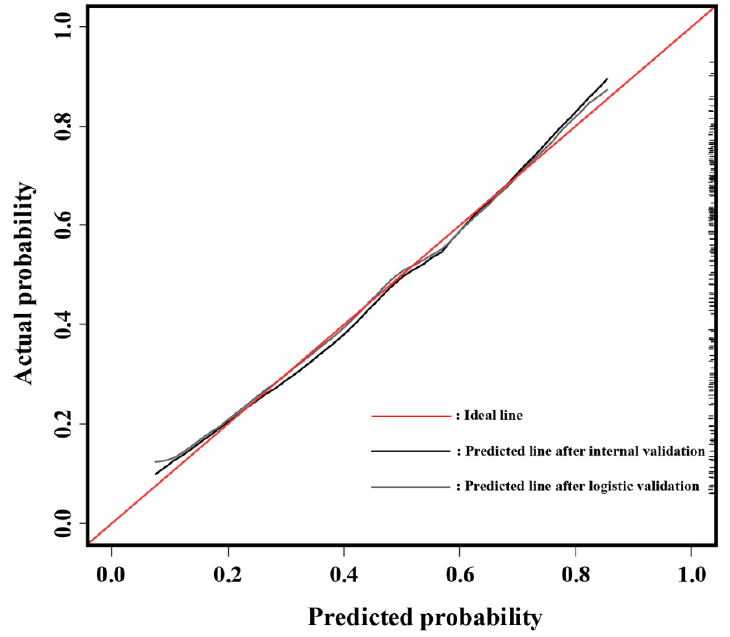
Figure 5. Model calibration plot for observed and predicted probability.